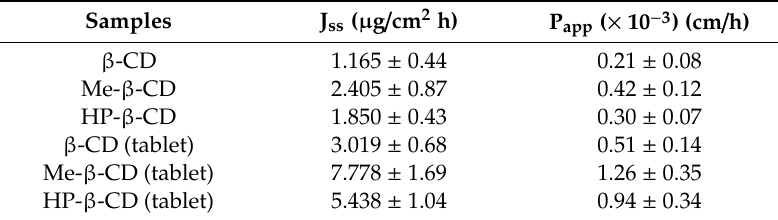
Table 3. Calculated steady state flux values (J ss ) and permeability coefficients (P app ) of free complexes and tablet form.